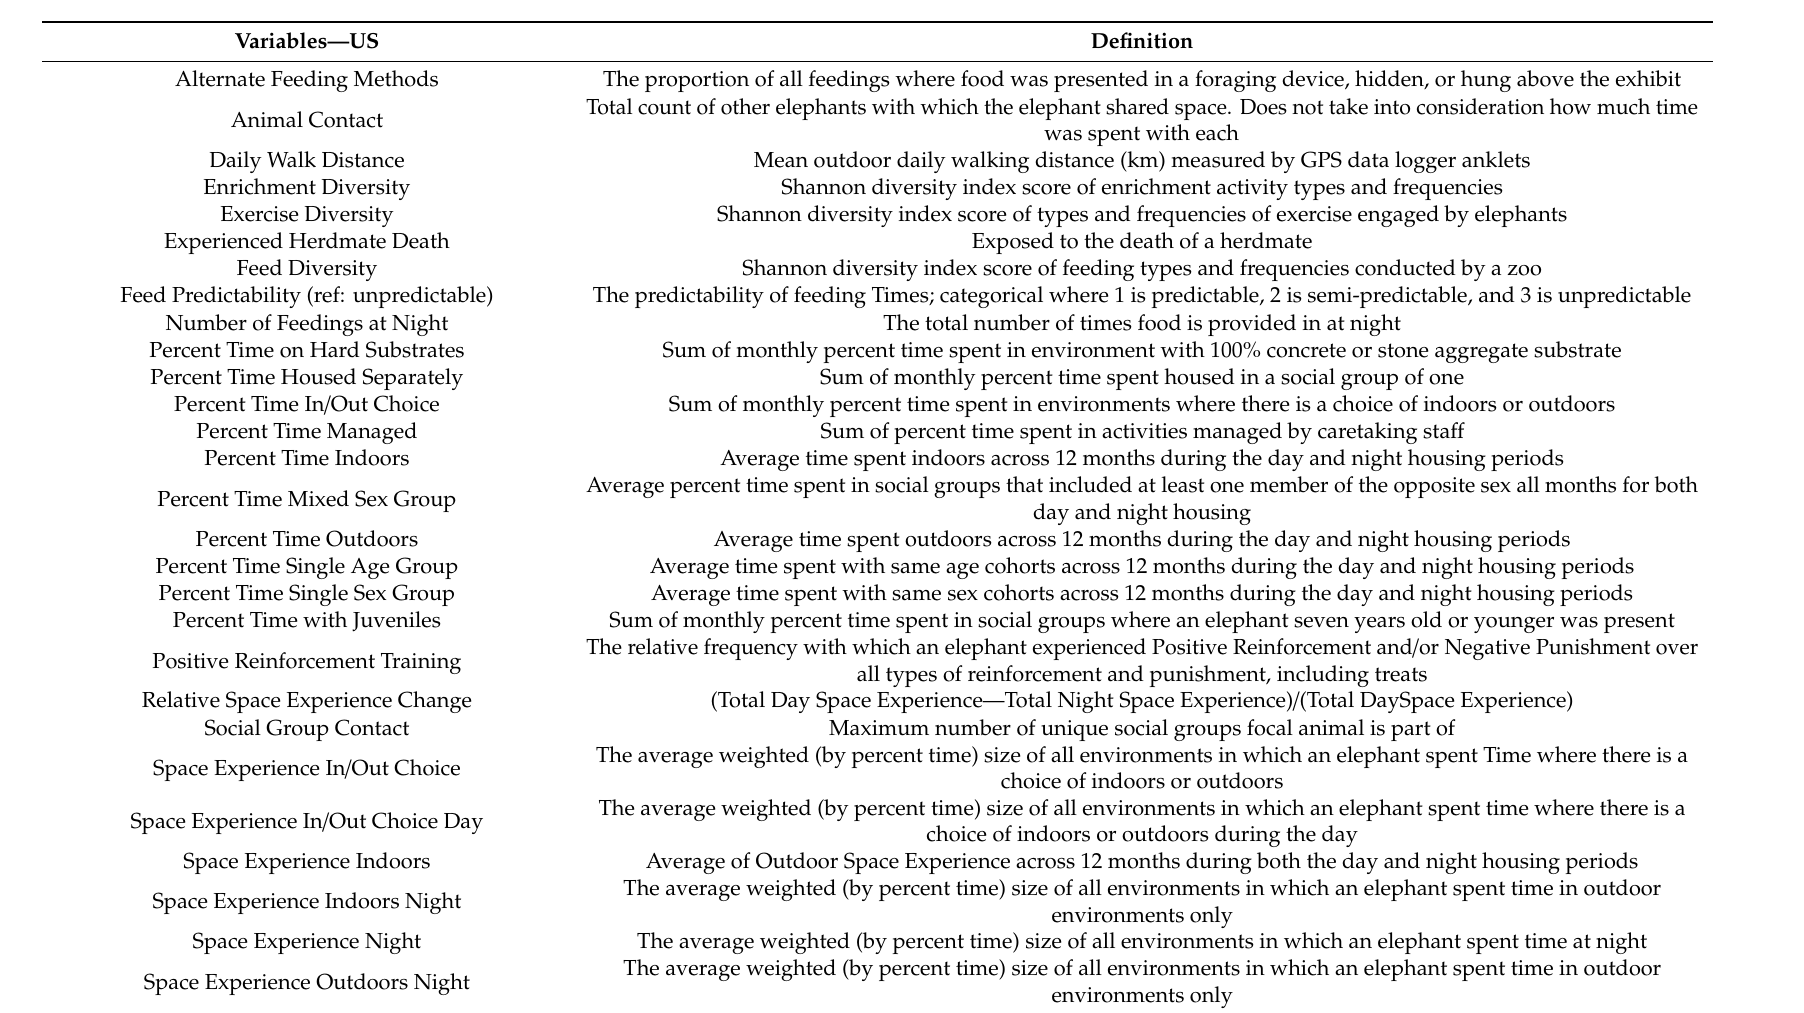
Table 1. Description of independent variables for General Estimating Equation models of welfare outcomes in epidemiological studies of Asian elephants in North America and